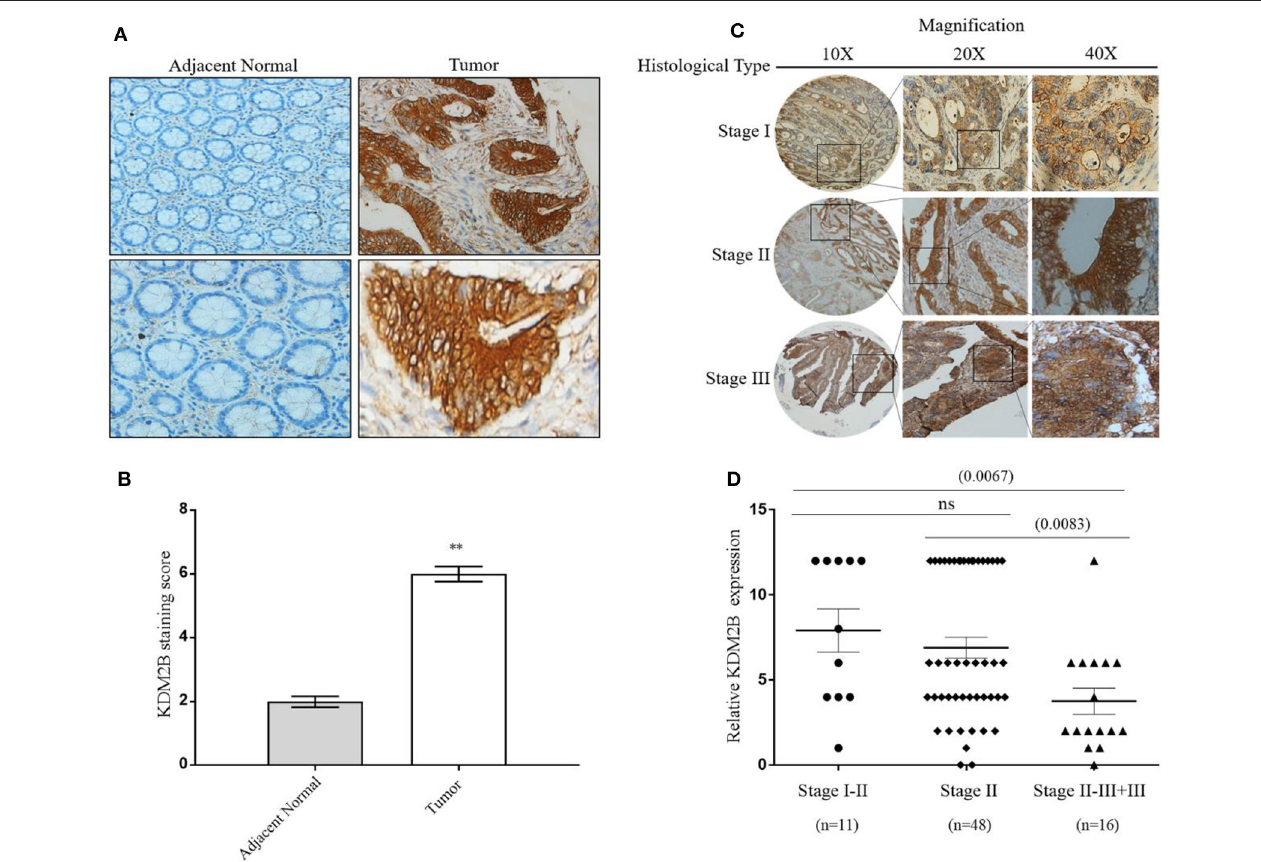
FIGURE 1 | KDM2B is overexpressed in colorectal cancer specimens. (A) KDM2B protein was analyzed by immunohistochemistry in the adjacent normal tissue (left) and tumor tissues (right). Cells with brown granules in the nucleus were identified as KDM2B positive. The magnification was × 20 and × 40, respectively. Scale bar = 100 µ m. (B) The results of KDM2B expression were evaluated by the staining scores. ** p < 0.01. (C) The images represent differential KDM2B staining intensities in different clinical stages. (D) The correlation between the expression of KDM2B and the clinical stage was analyzed between stage I–II, stage II, and stage II–III + III. Stage II–III and Stage III cases were combined into one group. Statistical significant differences were observed between groups (** p < 0.001).